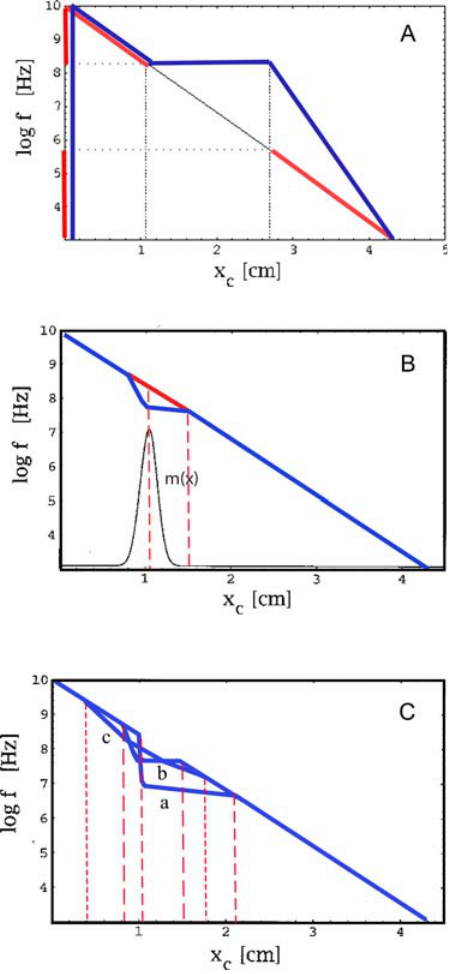
Figure 5. (a) TM constructed by discontinuous variation of the stiffness parameters a , E 0 , constructed according to part II of the theorem. Dotted lines indicate the defect region in frequency space ( f M [300,4000] Hz), dash-dotted lines the corresponding cochlea area. Red: TM before, blue: TM after remapping. (b) Bridging gaps by an additional Gaussian mass distribution m x ð Þ ~ m 0 1 z 1 ffiffiffiffi where s =0.1. Red: Relevant part of TM before, blue: TM after remapping. (c) Effects by additional Gaussian mass distributions of s : s M {0.01,0.1,1} (graphs a–c, respectively). The dashed lines indicate the essentially modified areas. The achieved space shifts on the TM are obtained by horizontals leading from the modified to the original TM.